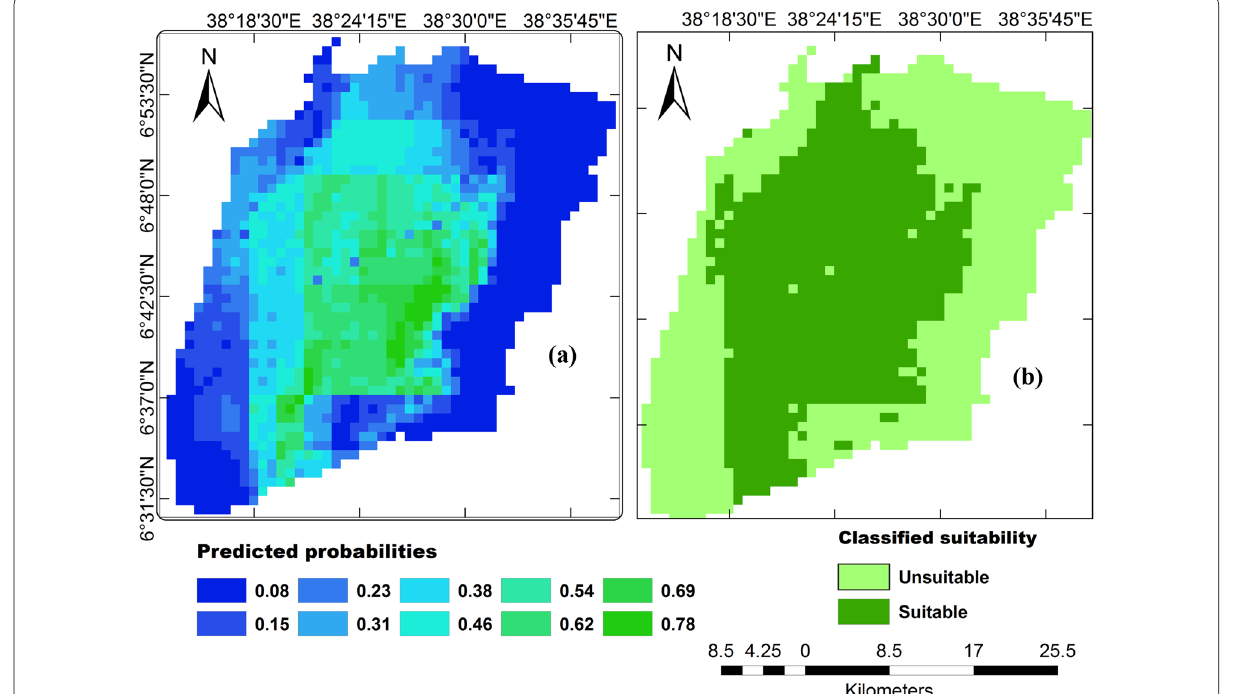
Fig. 2 Species’ distribution and habitat suitability map of P.